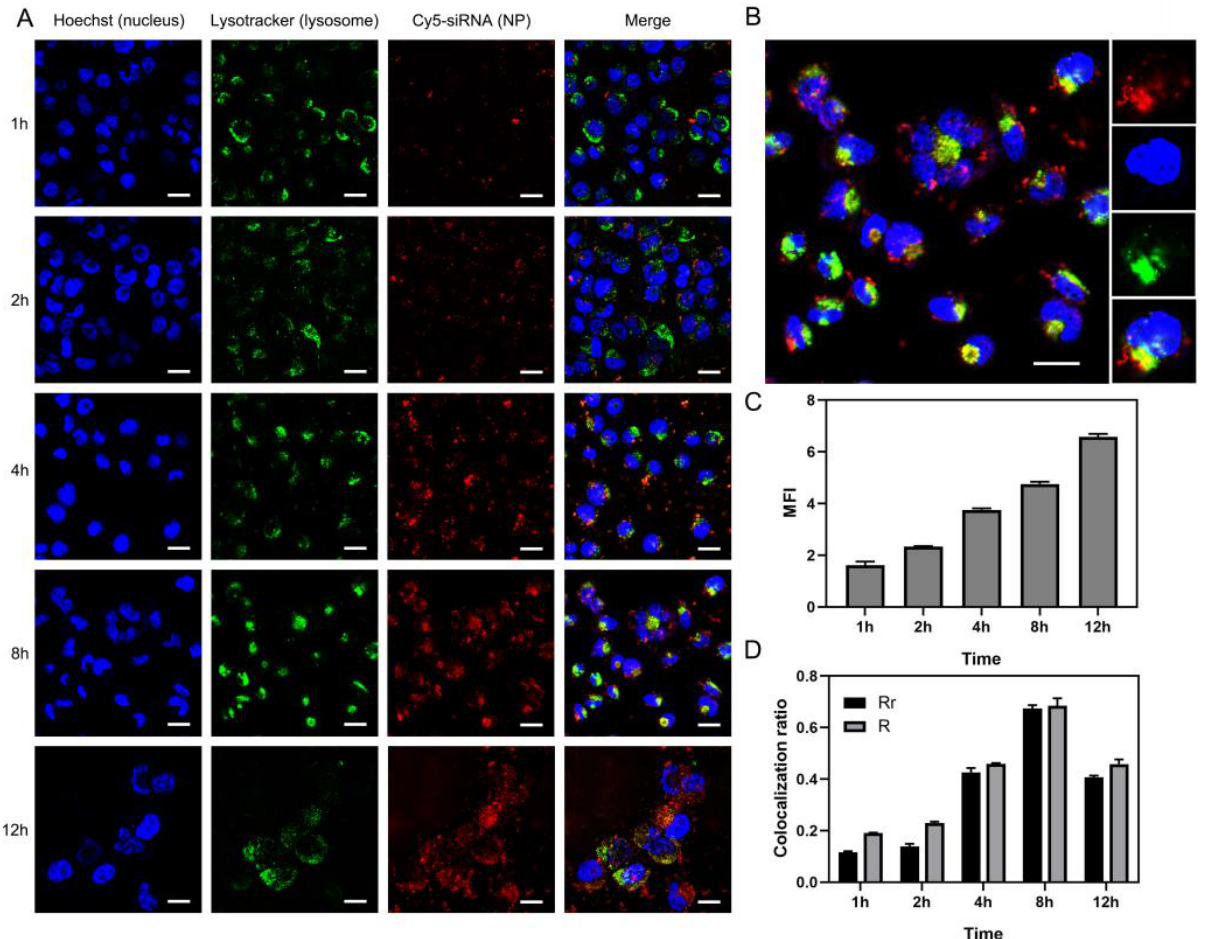
Figure 6. Subcellular localization and lysosomal escaping of CEL/Cy5-siRNA nanocomplexes in the HeLa – Luc cells. ( A ) Subcellular localization of CEL/Cy5-siRNA nanocomplexes in the HeLa – Luc cells observed with confocal laser scanning microscopy at different transfection time points. Nuclei were stained with Hoechst (blue), lysosomes were stained by Lysotracker (green). Cy5-siRNA (red)